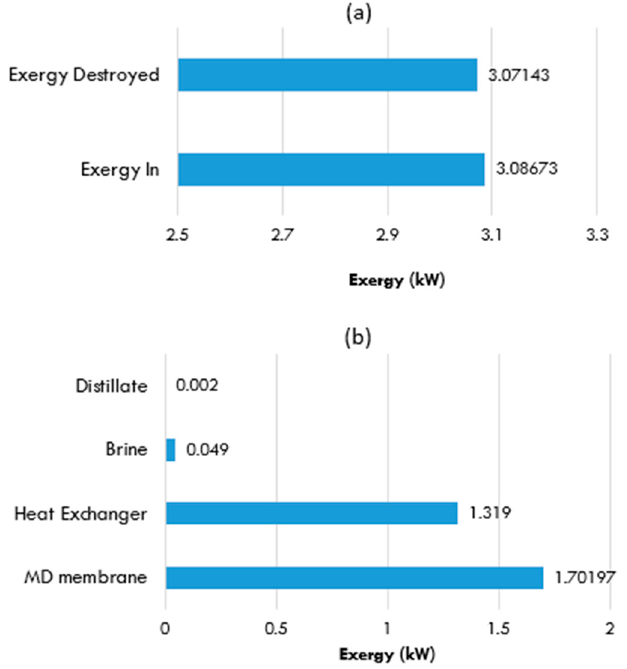
Figure 15. ( a ) Exergy balance of the solar powered MD unit with a heat exchanger; ( b ) exergy destruction in individual components.